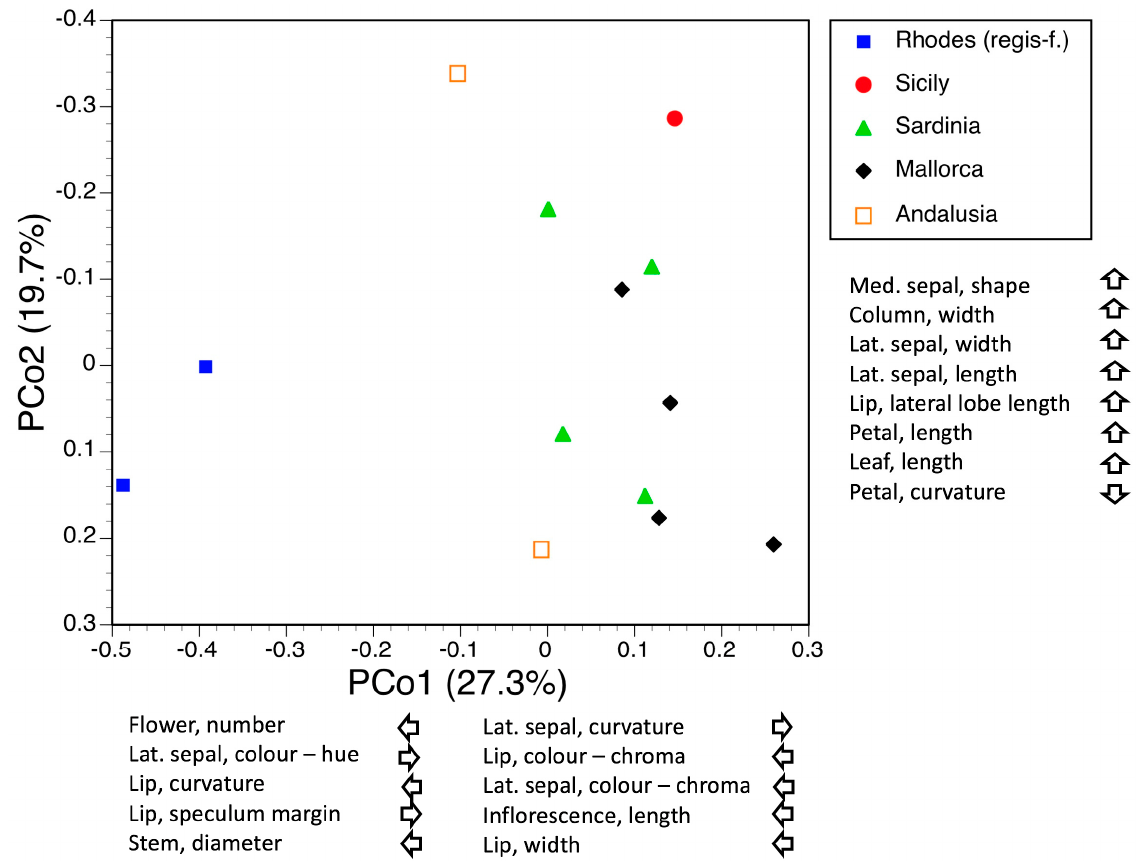
Figure 12. Plot of principal coordinates 1 and 2 for the macrospecies Speculum, labelled according to five regions of origin: 13 individuals from 12 localities and 42 variable characters. Characters contributing to each coordinate are listed in descending order, with arrows indicating the direction of increase in the value of each character.